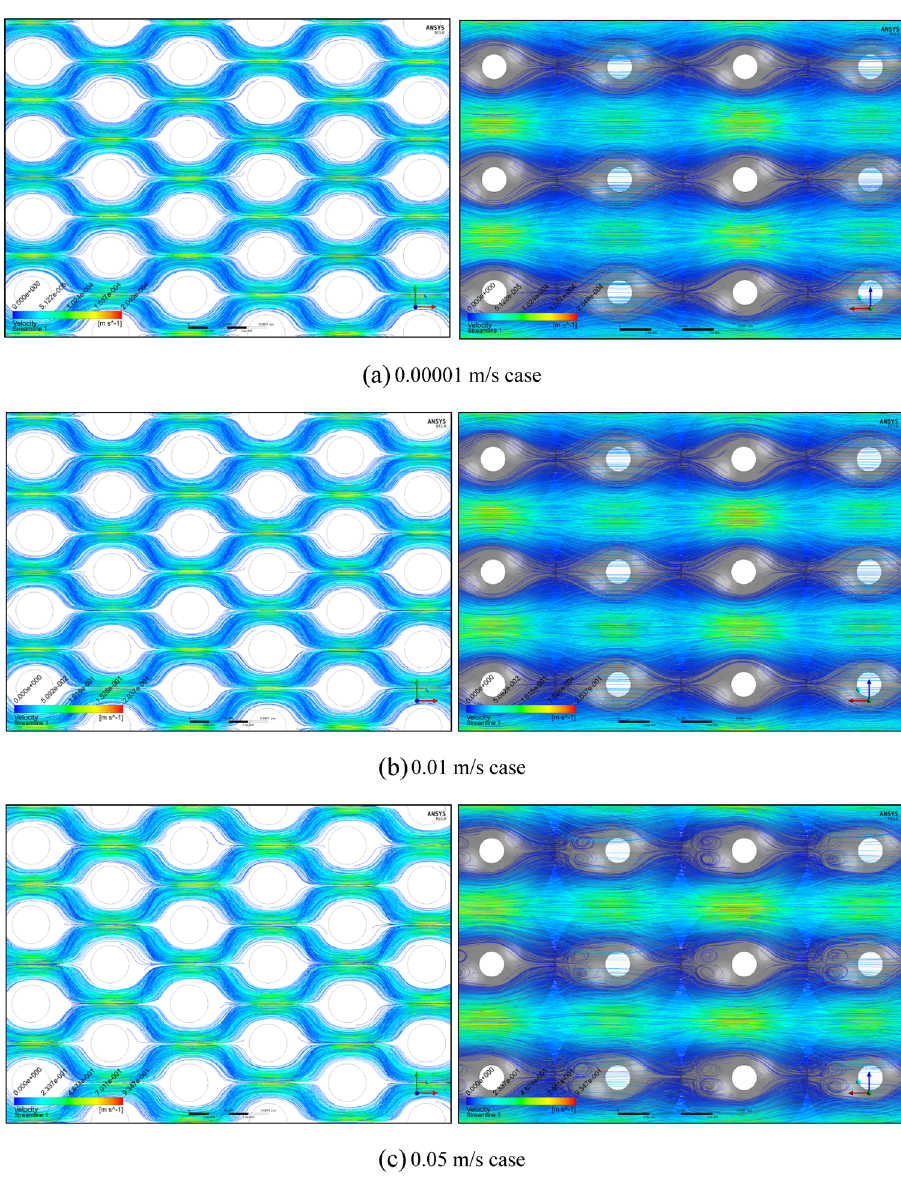
Figure 1. Streamline distributions of the mono-size pack models from (a) 0.00001 to (e) 0.75 m/s conditions, focusing on the centre parts in the X–Y (left) and X–Z (right)